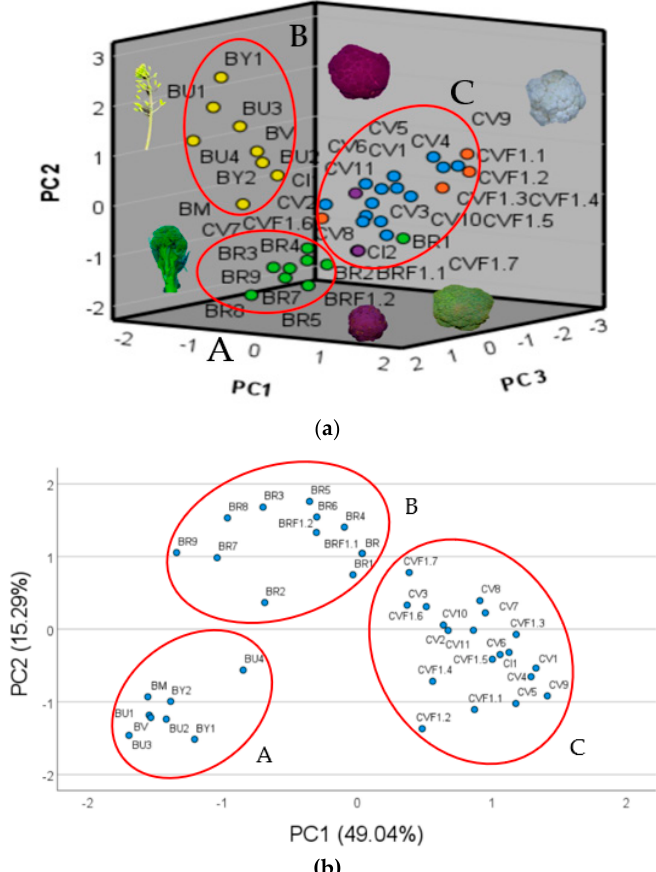
Figure 1. PCA plot performed utilizing 20 alleles selected for the primers utilized and all the inflorescence descriptors ( a ) and PCA plot performed utilizing the 5 more highly correlated alleles with the inflorescence traits ( b ), respectively.